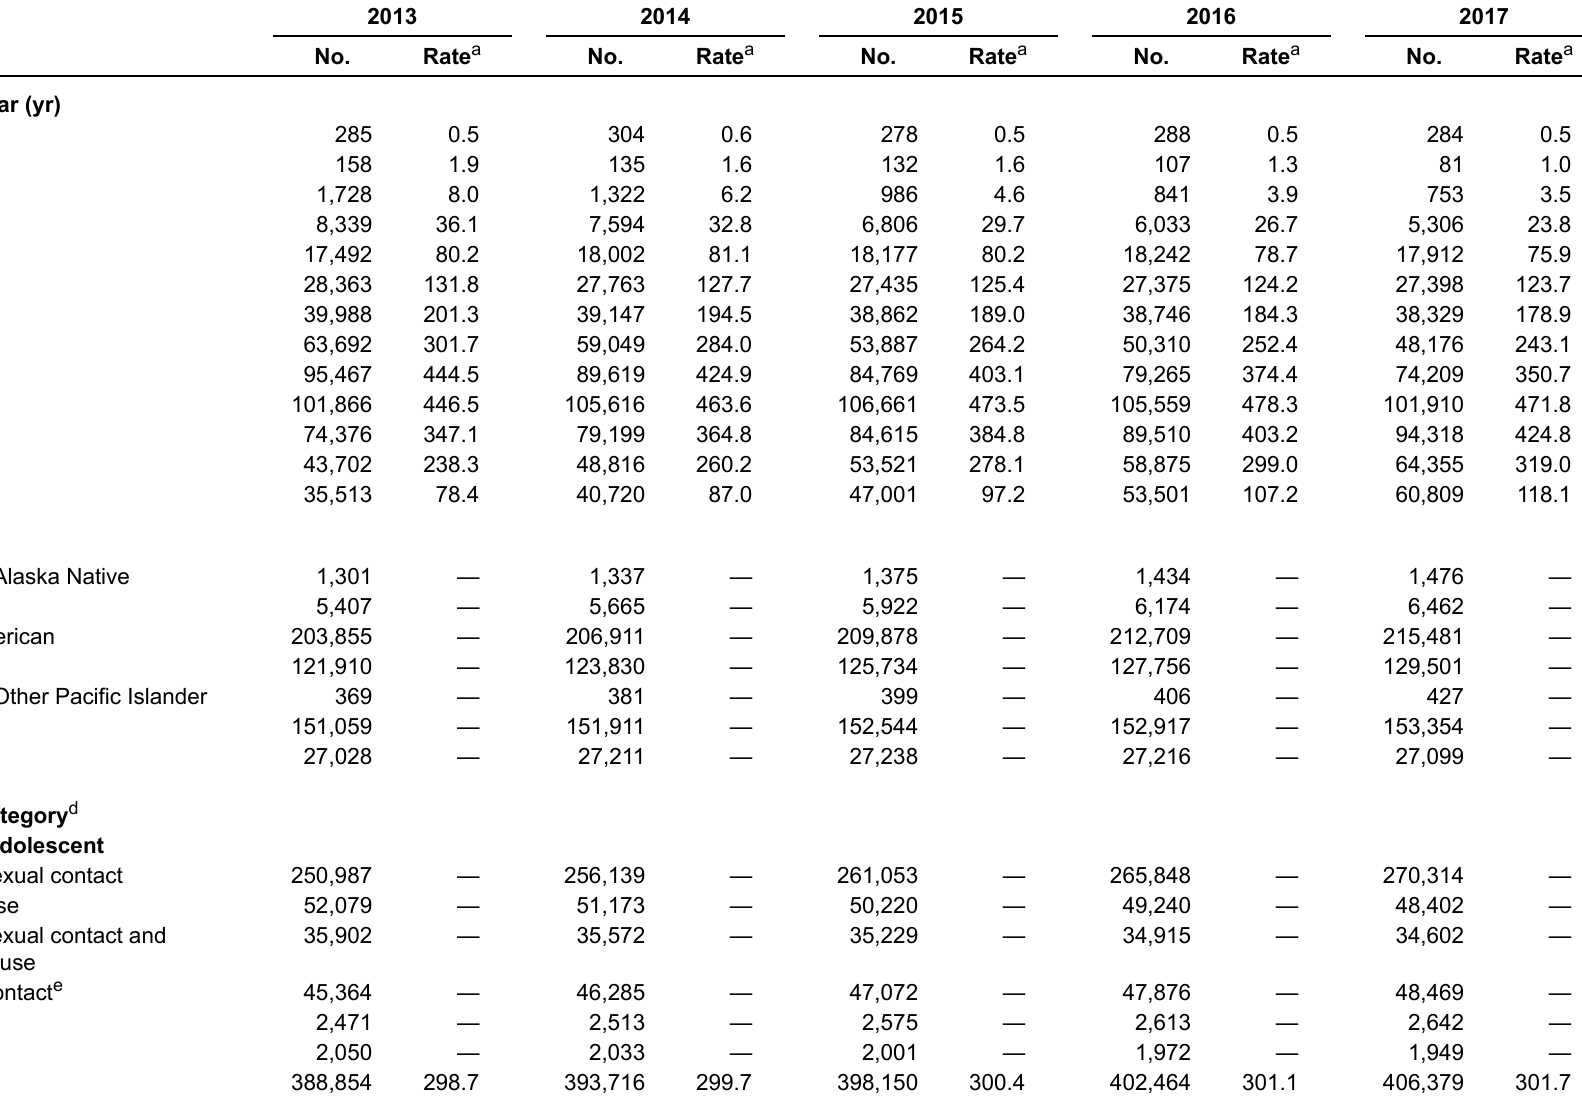
Table 23b. Persons living with diagnosed HIV infection ever classified as stage 3 (AIDS), by year and selected characteristics, 2013–2017—United States